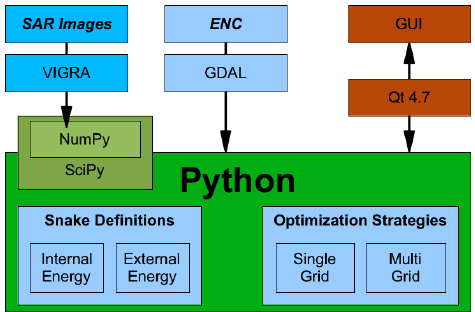
Figure 2: The components of the first framework. Python in con- junction with NumPy and SciPy forms the basis, Qt is used for interaction, VIGRA and GDAL for external image and ENC ac- cess. Data sources are highlighted italic bold and interchangeable modules are filled with light blue color.